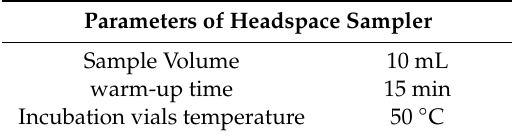
Table 1. Parameters used in the experiments of Escherichia coli discrimination.